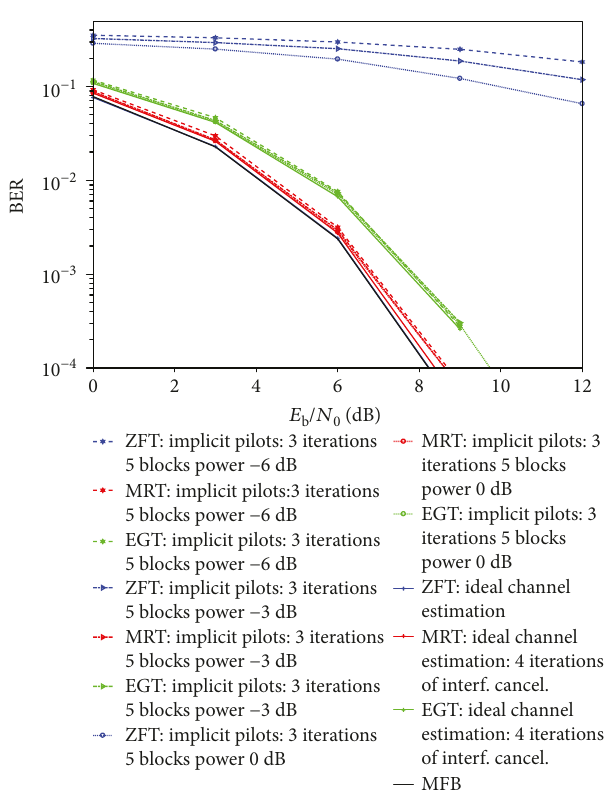
Figure 8: BER results with 32 × 2 using implicit pilots with 5 data blocks, 3 iterations, and a pilot power of − 6 dB, − 3dB, and